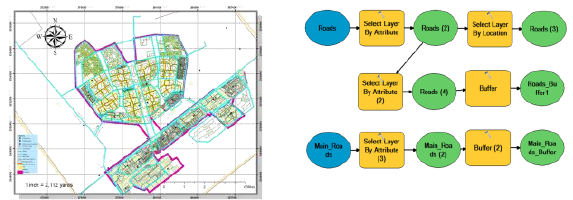
Figure 7. Public / private Transportation condition